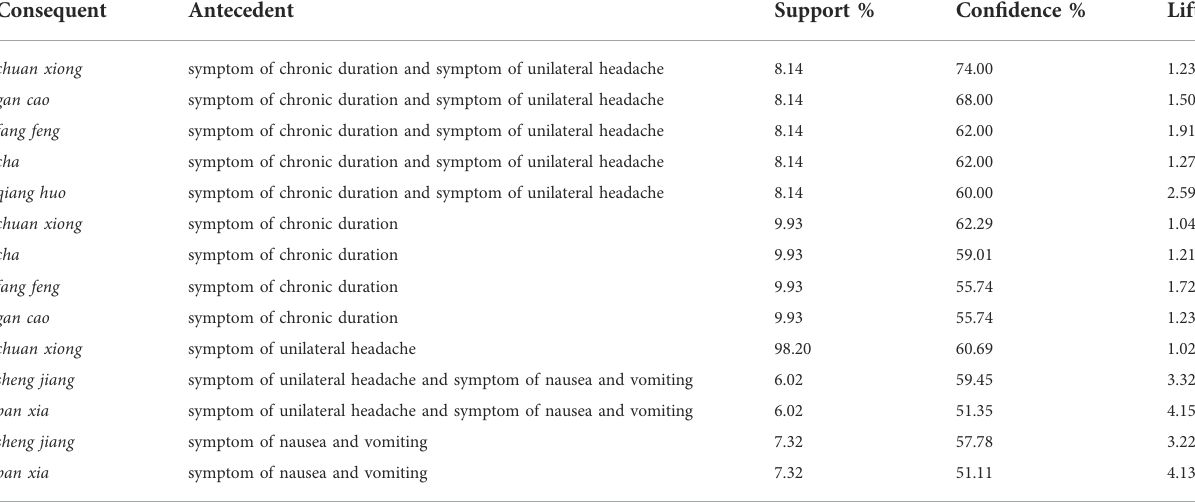
TABLE 4 Associations between symptoms and